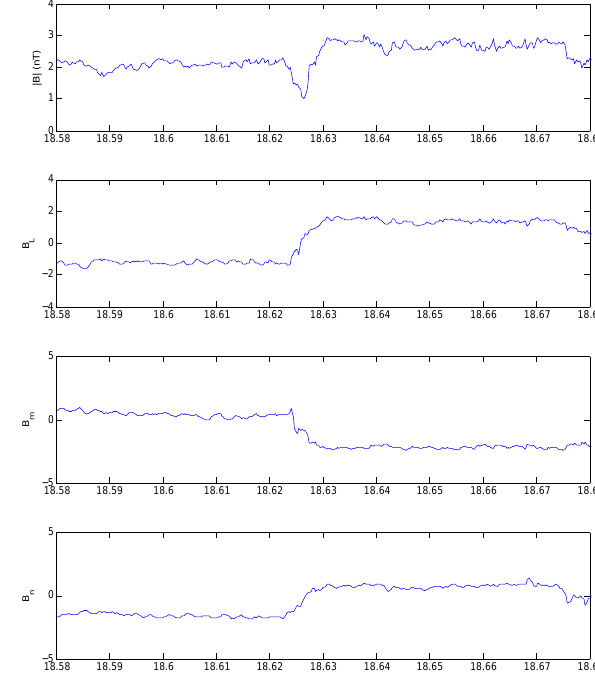
Fig. 9. Shock H: observed by ACE at 19.86UTC on 31 July 2007. See caption of Fig. 7 for | B | , B L , B m and B n .